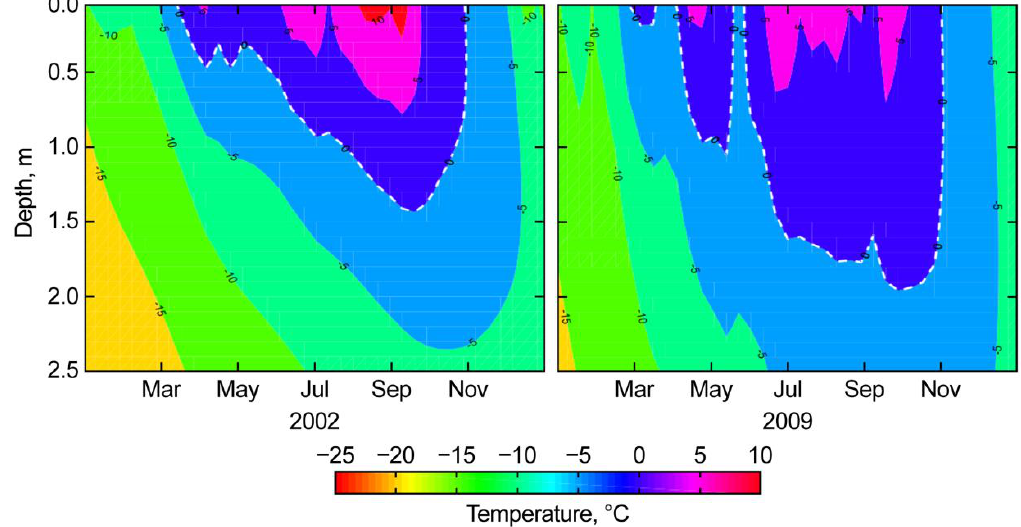
Figure 13. The thermal profiles calculated using a heat-transfer model [62–64] for an ice-rich permafrost region in the Fenghuo Shan site (34.69 ◦ N and 92.89 ◦ E, 4938 m asl) in Tibet. The white dashed lines are the 0 ◦ C isotherms that are used to determine the active-layer thickness. The modeled values are consistent with in-situ measured changes in active-layer thickness from 1.4 to 1.9 m between 2002 and 2009 [65].